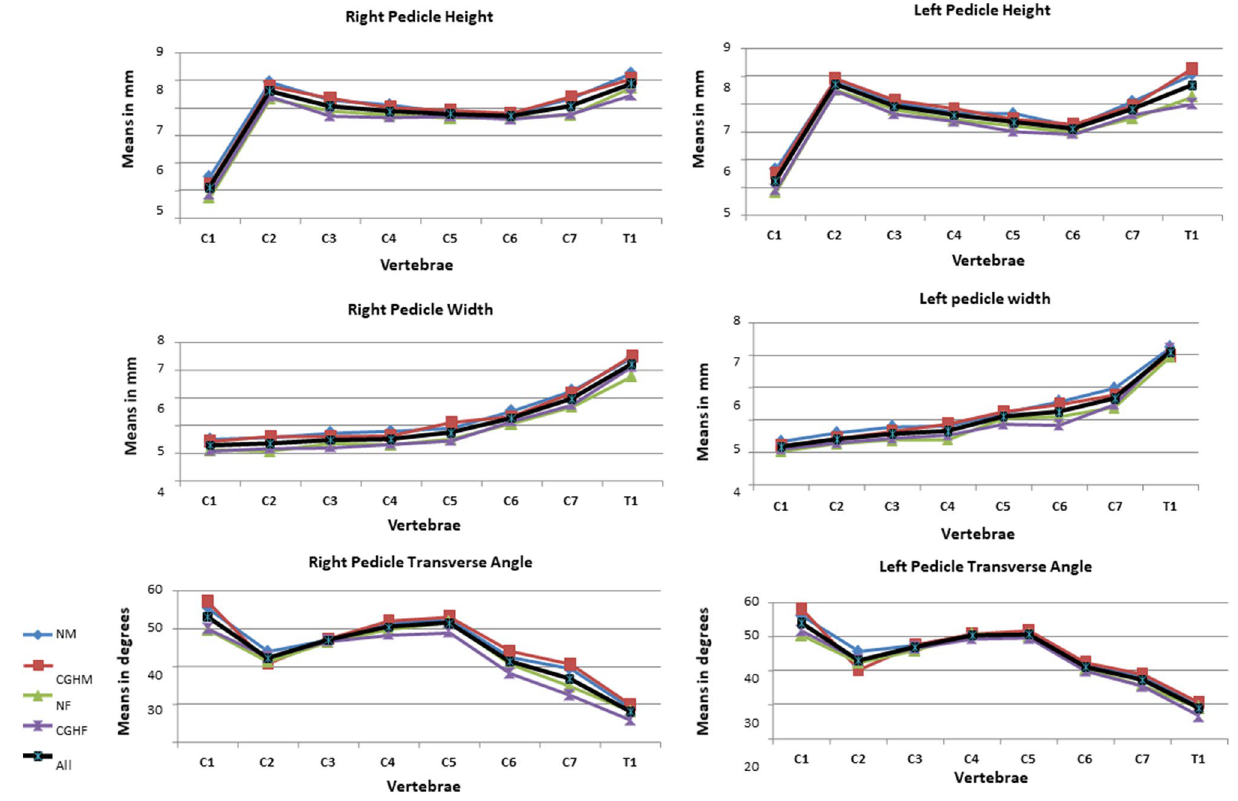
Figure 3. Pedicle shape variation along the cervical spine. NM normal males, CEHM cervicogenic headaches males, NF Normal females, CEHF cervicogenic headaches females, All all individuals